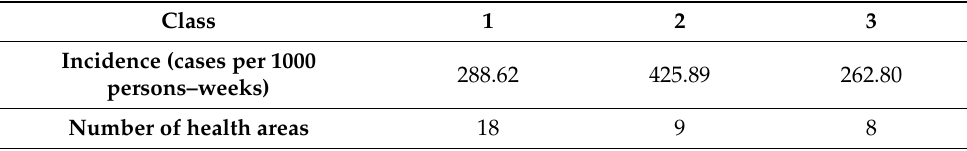
Table 5. Classes of malaria risk according to the number of health areas and to meteorological and environmental